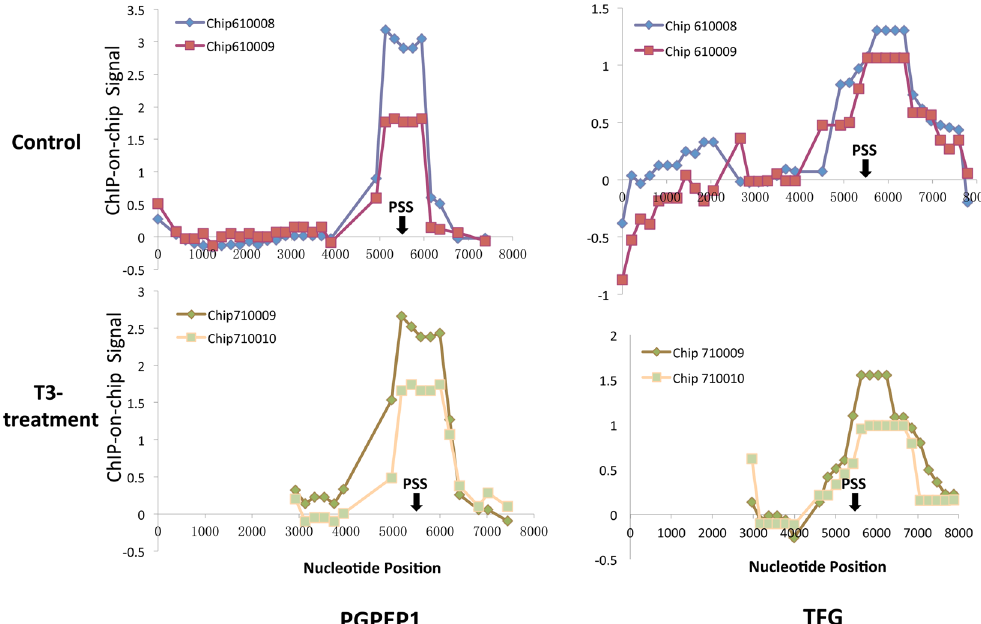
Figure 2. The ChIP signals across the 8000 bp promoter region for PGPEP1 and TFG1 from the control and T3 treated tadpole intestine. Both the control and T3-treated groups had two independent samples as shown. The arrow points to the putative start site